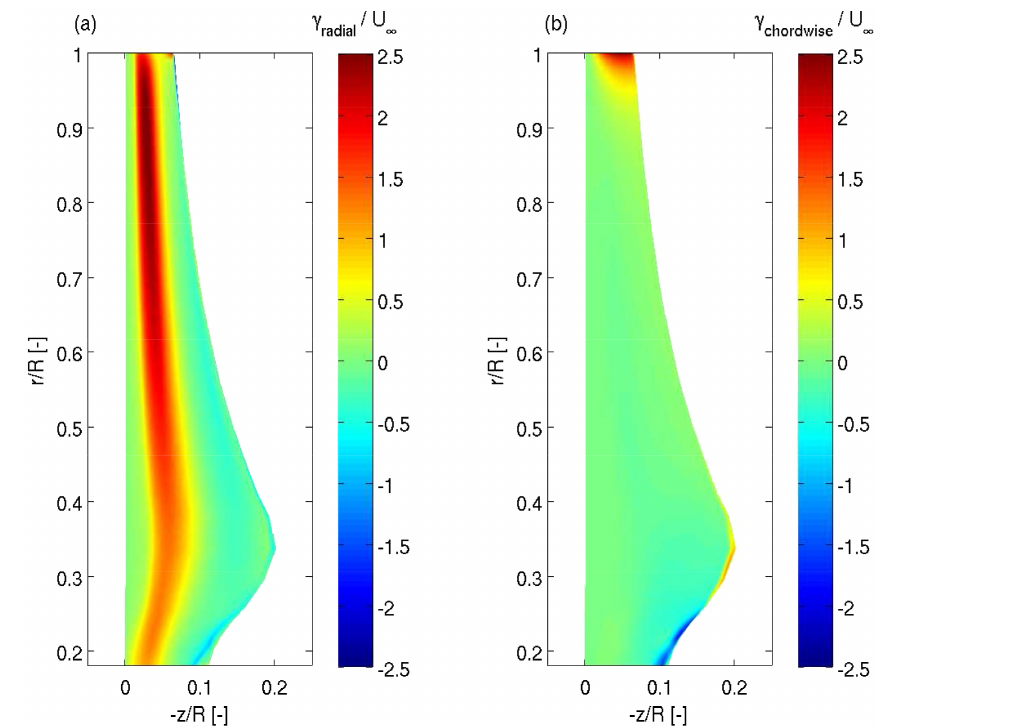
Figure 14. Radial and chordwise components of the bound vorticity.